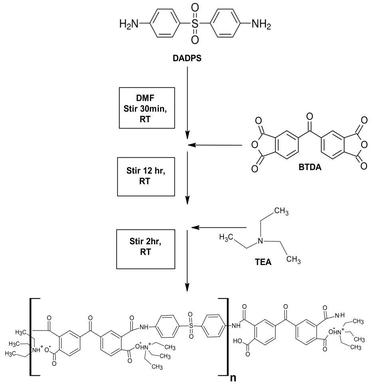
The synthesis scheme of the PAAS-T precursor resin.